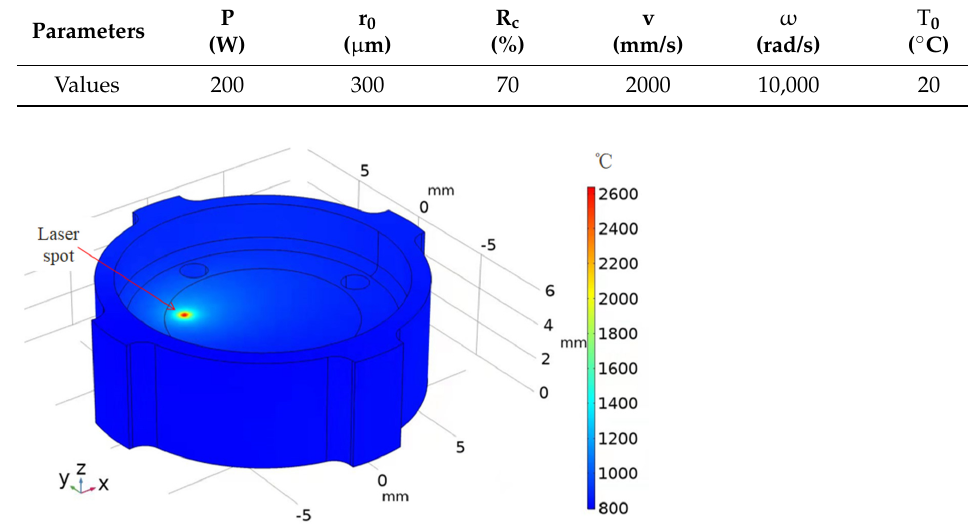
Figure 11. Temperature distribution of the workpiece at the end of laser processing.